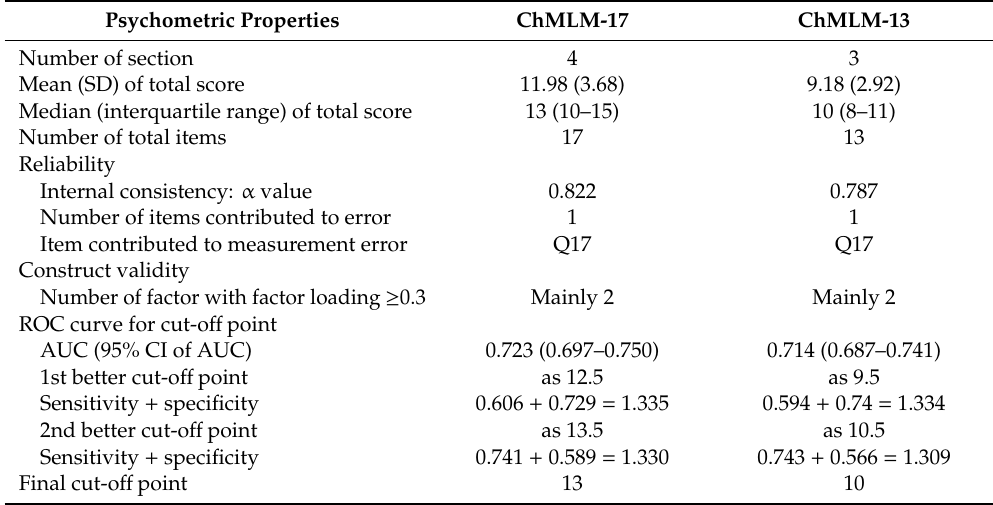
Table 3. Psychometric properties of the ChMLM-17 and ChMLM-13.